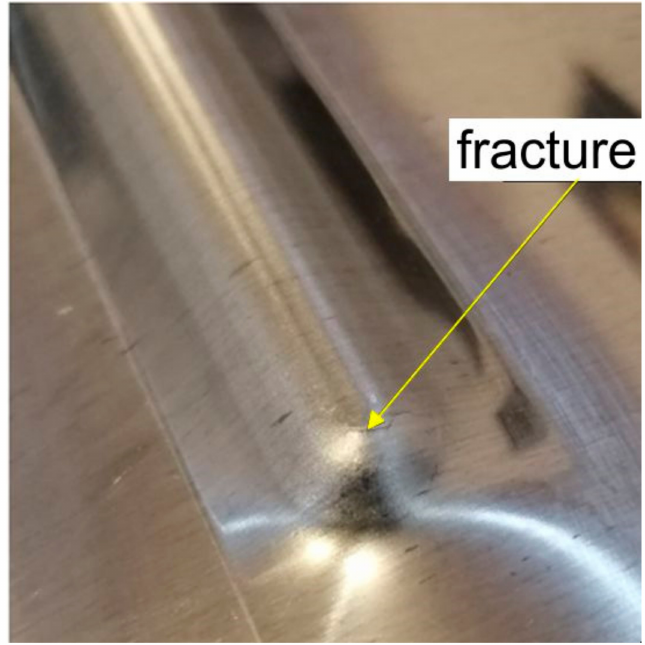
Figure 4. Fracture in the corner of the rib formed in 0.4-mm-thick EN AW-2024-T3 sheet.